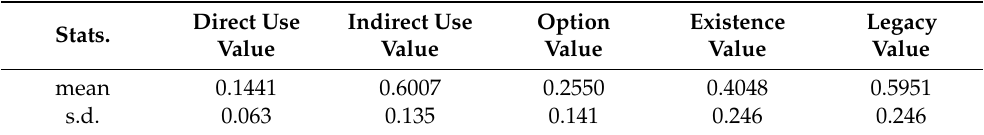
Table 6. Heterogeneity among the decision-makers’ priorities.